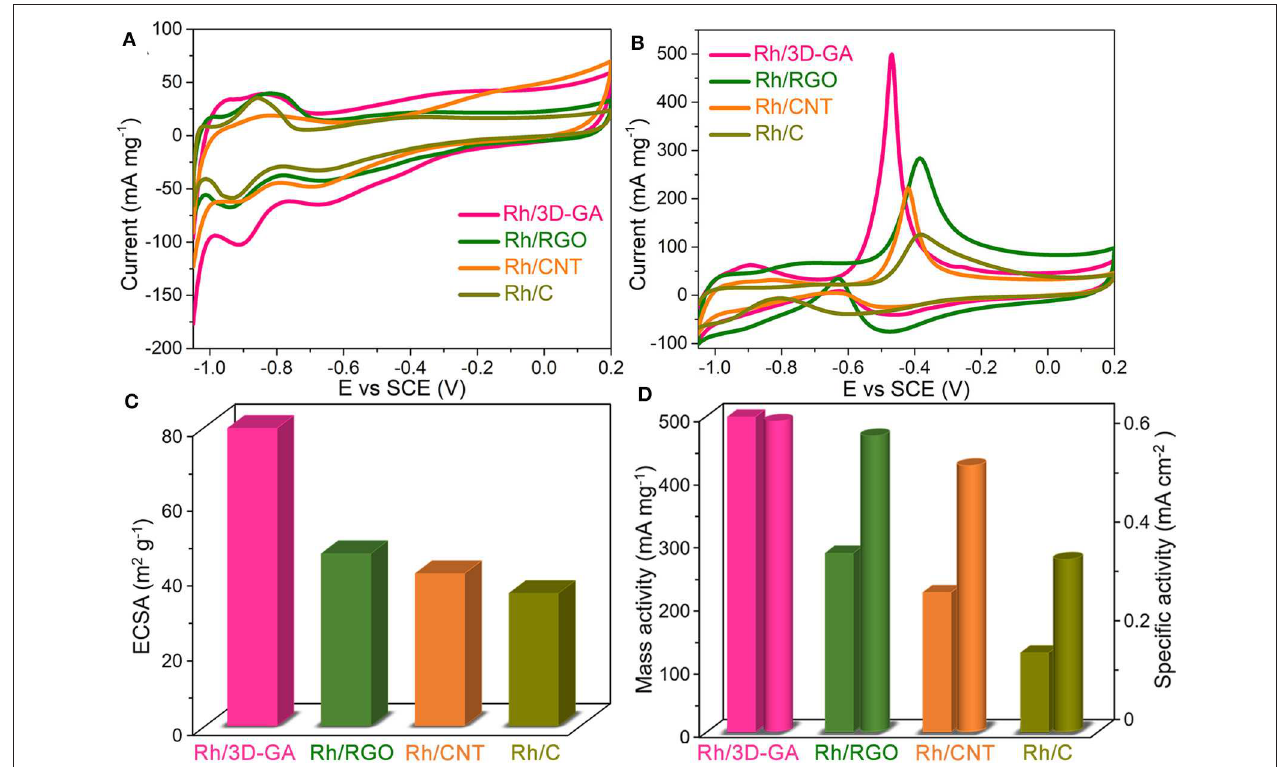
FIGURE 3 | CV curves of the Rh/3D-GA, Rh/RGO, Rh/CNT, and Rh/C electrodes recorded in (A) 1M KOH and (B) 1M KOH with 1M CH 3 OH solution at 50mV s − 1 . (C) Specific ECSA values and (D) mass activity as well as specific activity (normalized by ECSA) for these four catalysts.